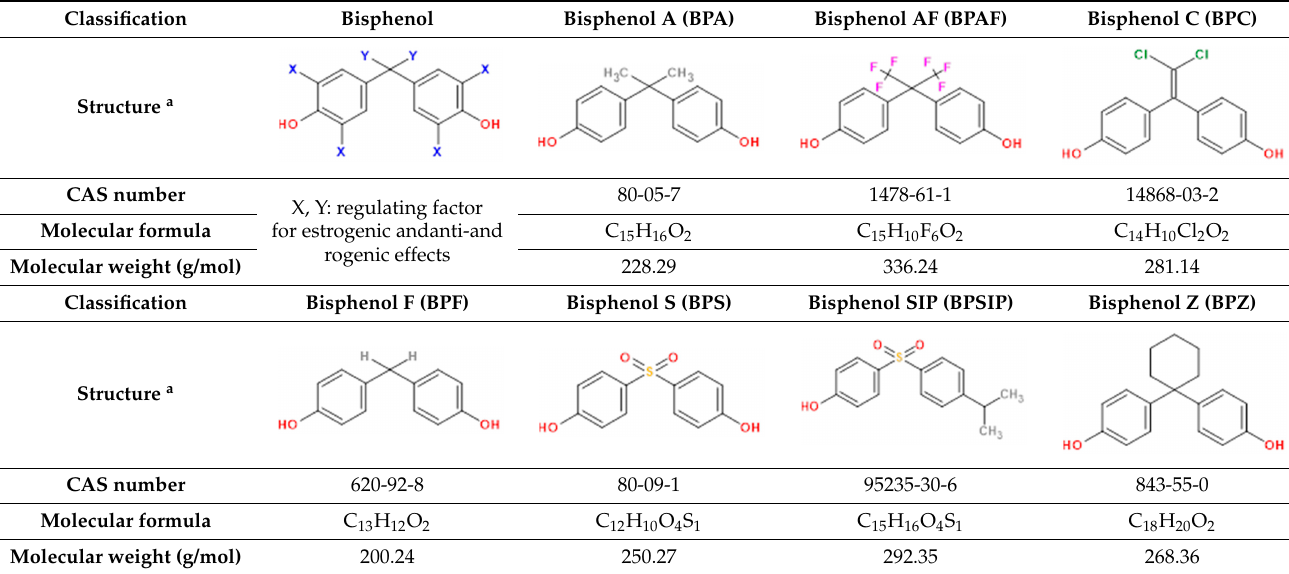
Table 1. Structural resemblance of bisphenol A analogs.